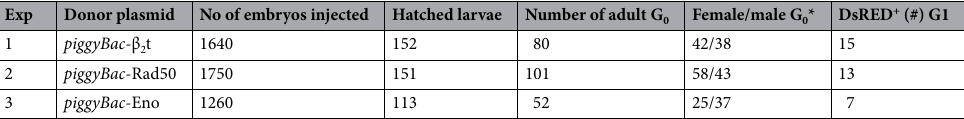
Table 1. Summary of piggyBac based transformation experiments. *Crossed the G 0 putative transgenic female with w −/− male in single pair cross or in pool of two to four beetles and vice versa. G1 larvae were screened for the DsRED fluorescence in eye.